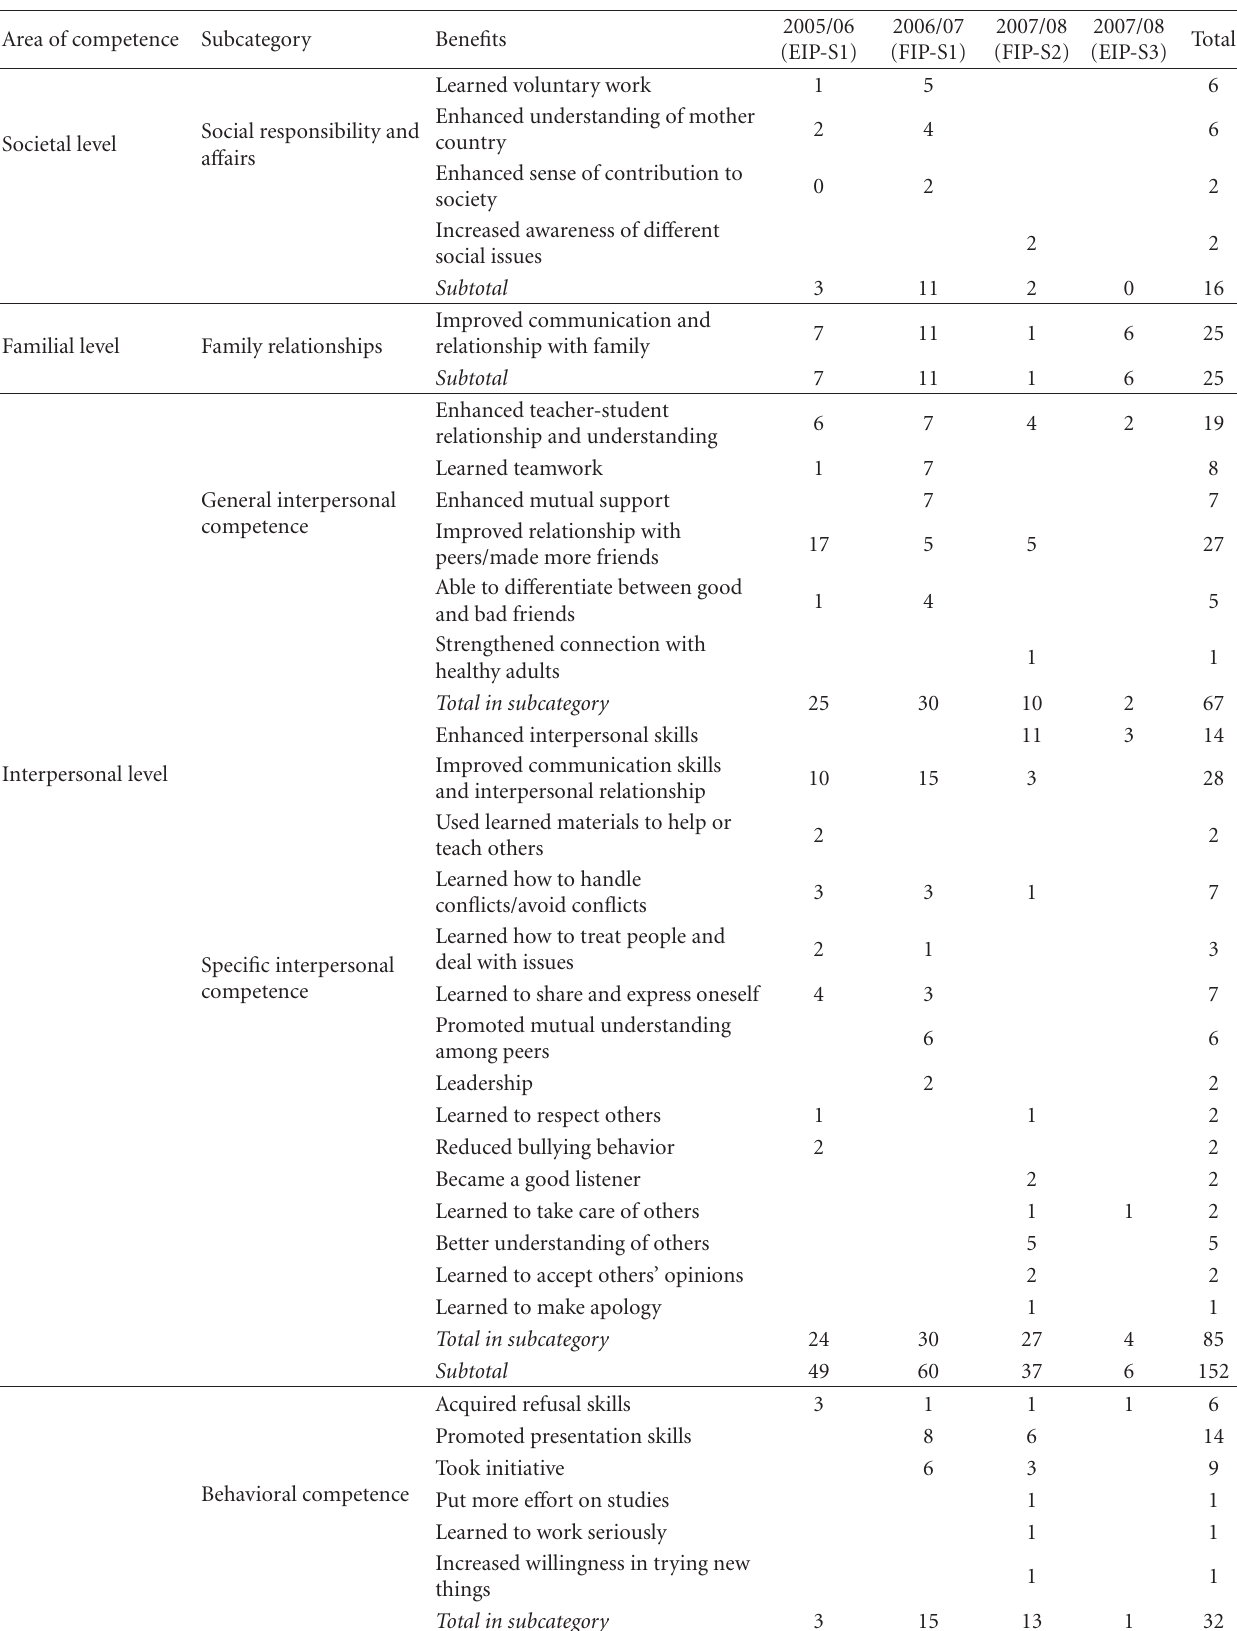
Table 5: Categorization of responses on the perceived benefits of and things learned in the program. Area of competence Subcategory